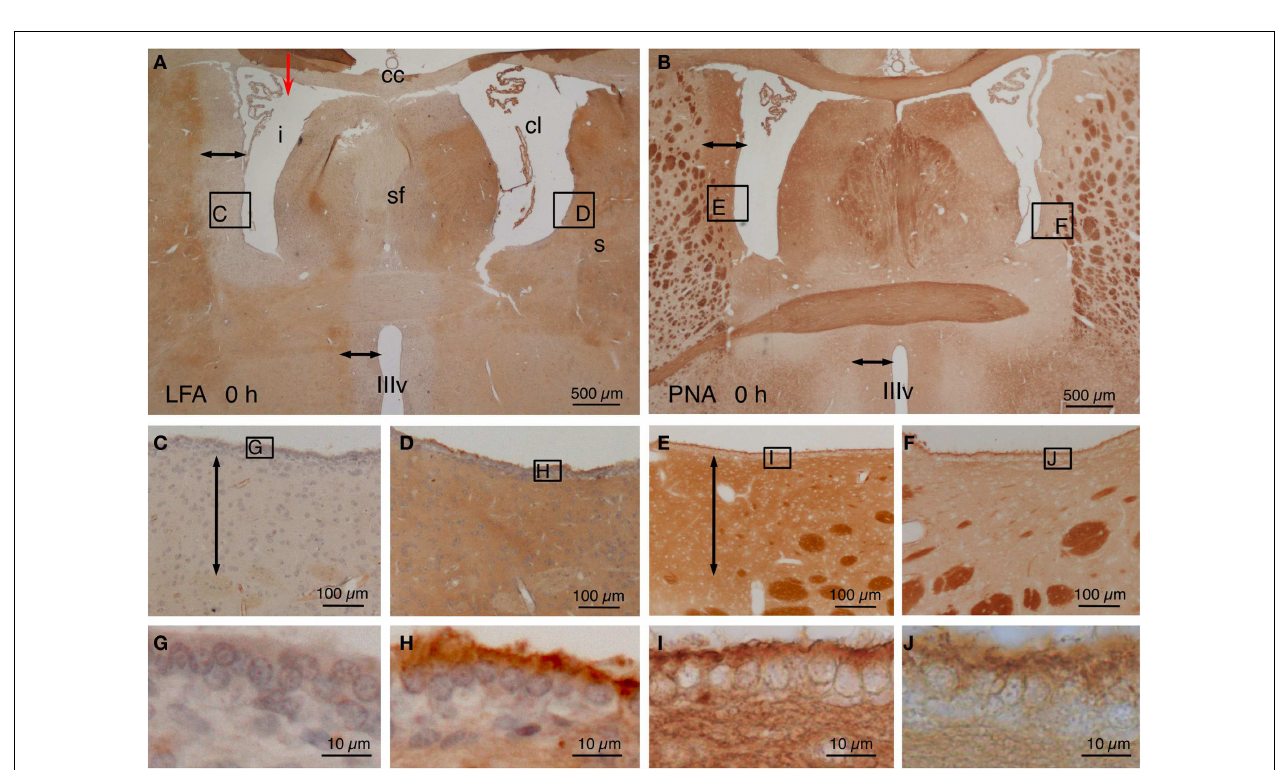
shown in detail in the following pictures. (G–J) The surface of the ependymal cells was LFA-negative (G) and PNA-positive (I) in the injected ventricle, whereas it was LFA-positive (H) and almost PNA-negative (J) in the contralateral ventricle. cc, corpus callosum; cl, contralateral ventricle; i, injected lateral ventricle; s, striatum; sf, septum-fimbria; IIIv, third ventricle. Sections in (A,C,D,G,H) were counterstained with